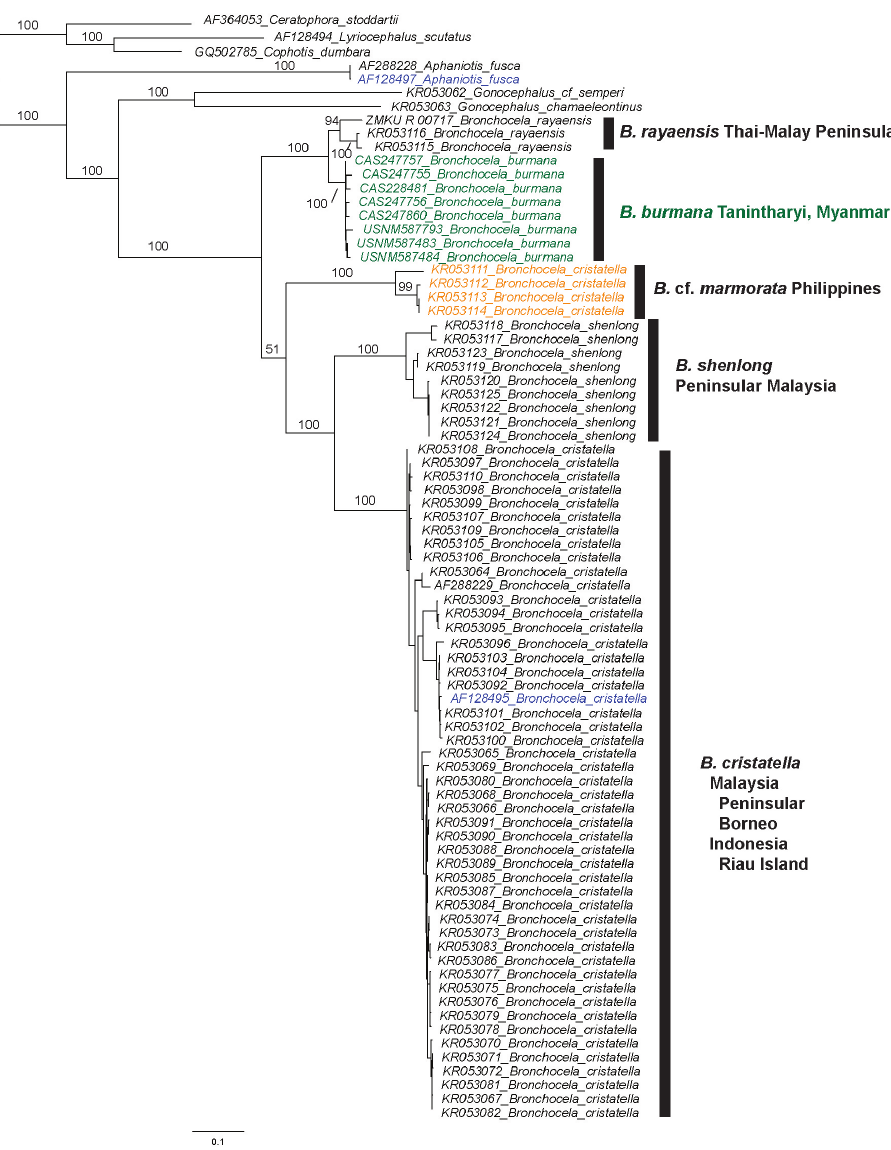
Figure 2. Phylogenetic relationships of Bronchocela . Maximum-likelihood phylogeny based on 1,416 bp of ND2 mtDNA, bootstrap values (based on 1,000 replicates) are shown for the major nodes relevant to this study. Terminals highlighted in blue were recently corrected in GenBank and the B. cristatella from the Philippines (in yellow) are now re-identified as B. cf. marmorata